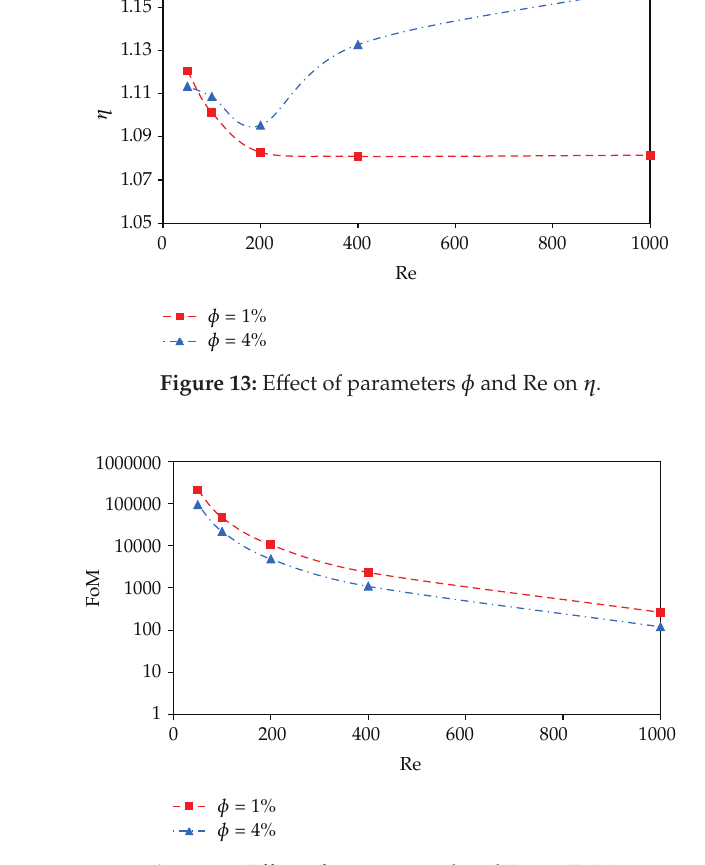
Figure 14: E ff ect of parameters φ and Re on